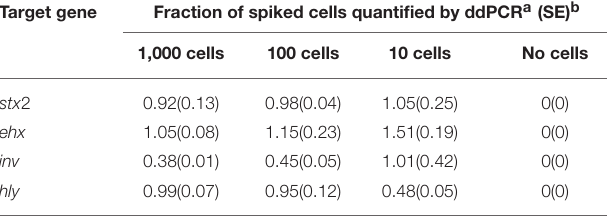
TABLE 4 | Sensitivity test using final sonication method. Target gene